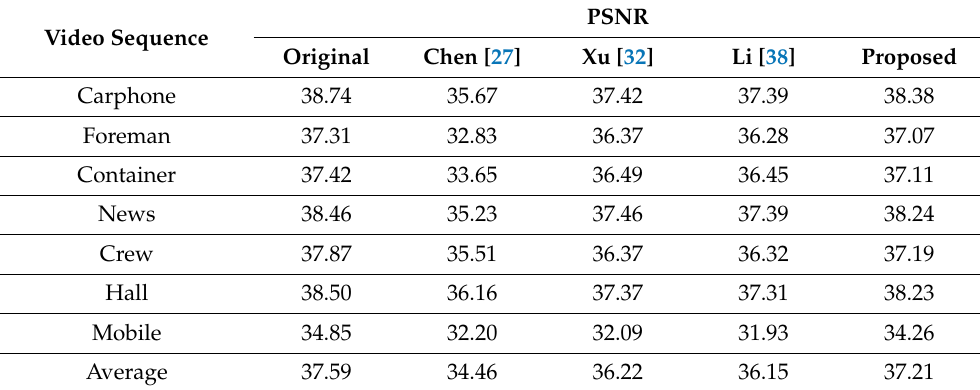
Figure 8. Comparison of PSNR values of different schemes on Foreman.